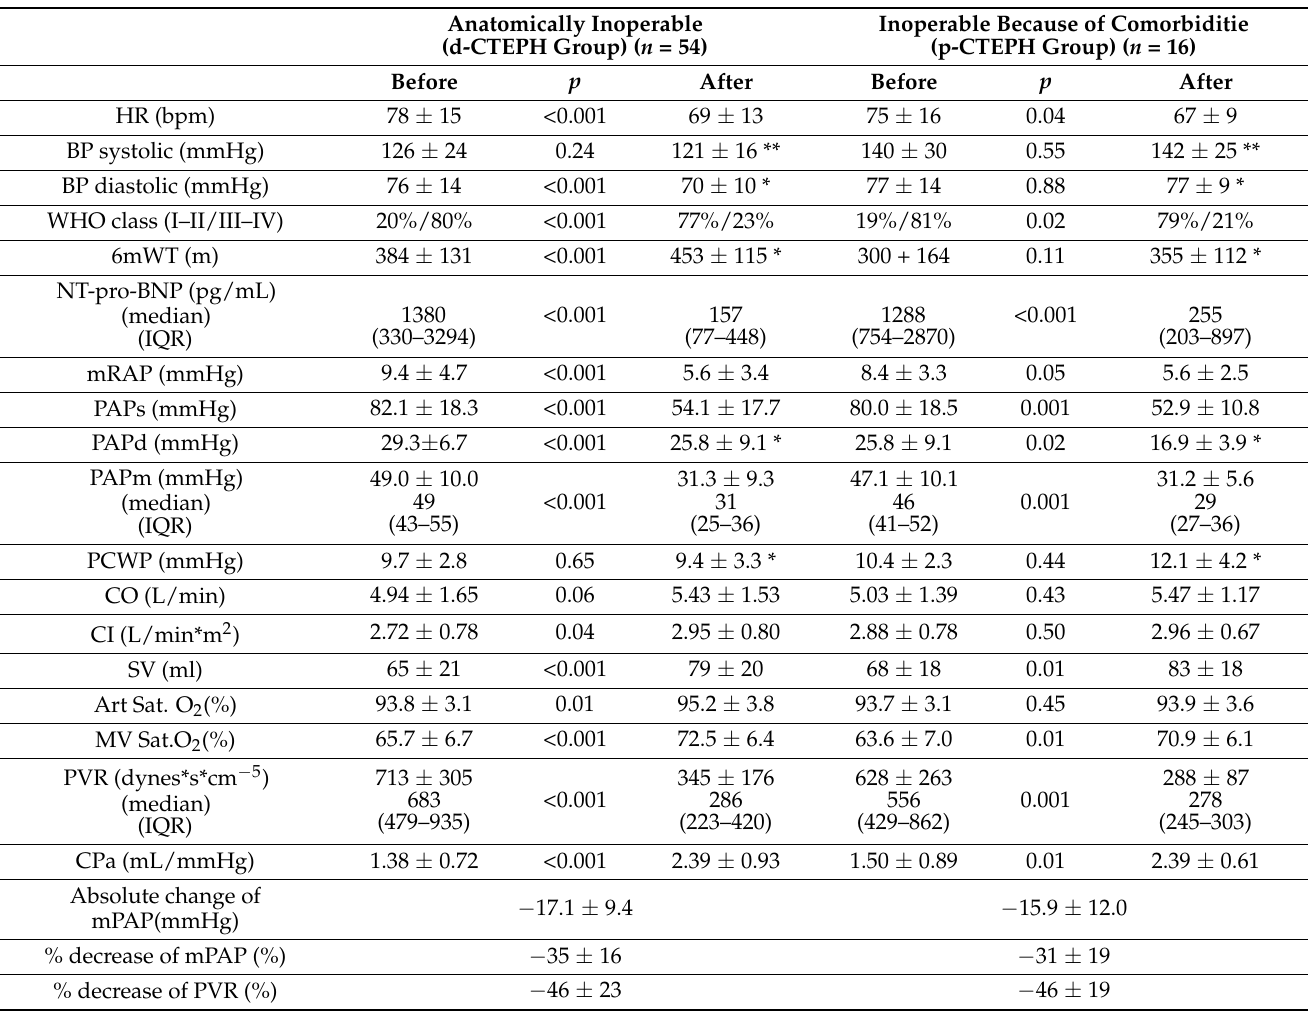
Table 3. Clinical and hemodynamic effect of BPA in anatomically inoperable patients (d-CTEPH) and inoperable patients because of comorbidities or patients’ refusal (p-CTEPH). Anatomically Inoperable (d-CTEPH Group) ( n =